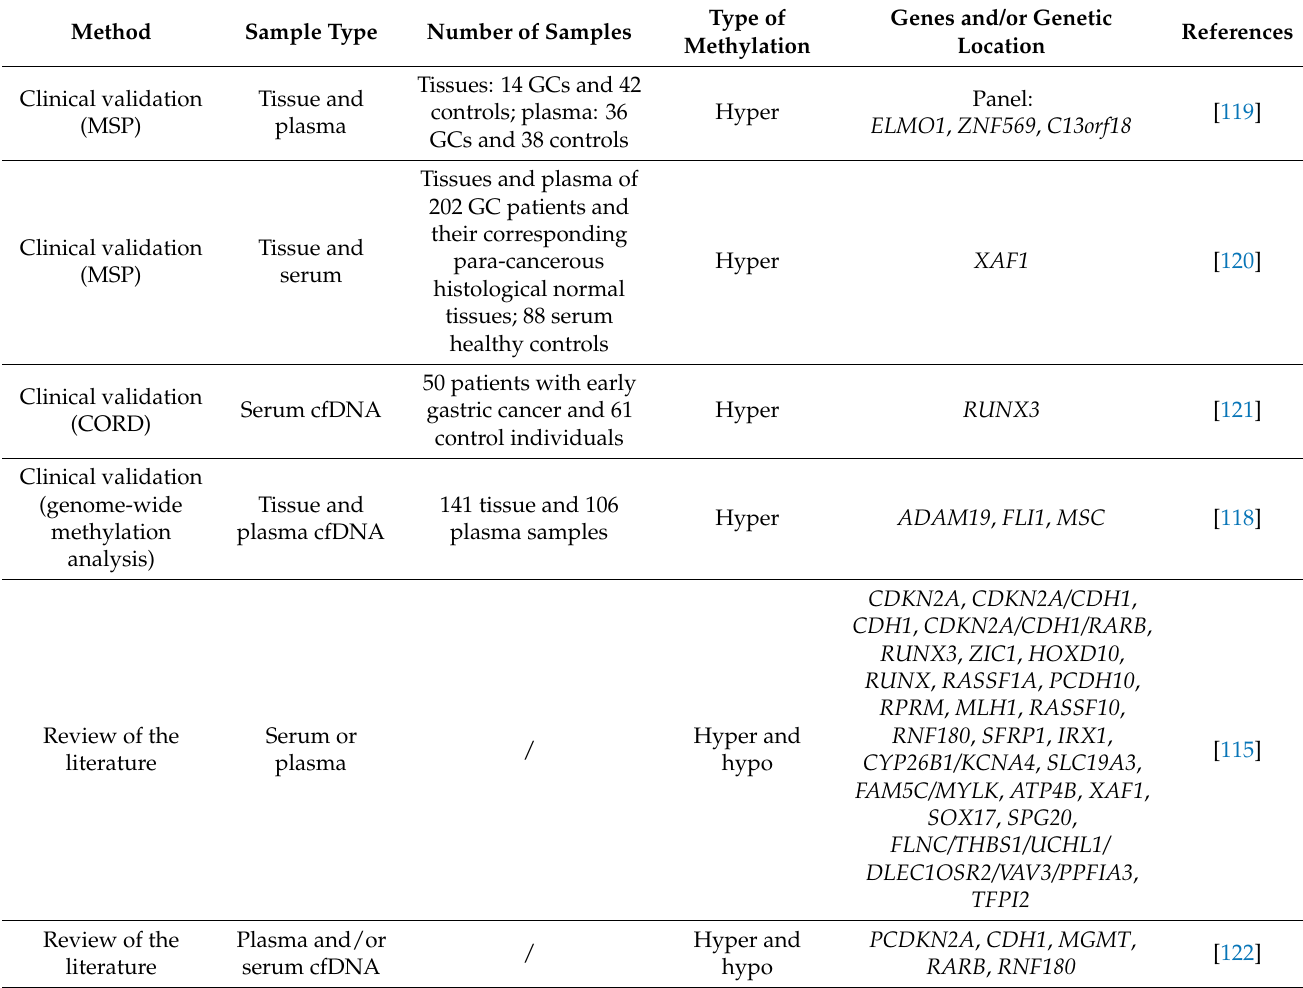
Table 6. An overview of methylation biomarkers for gastric cancer in liquid biopsy. cfDNA: